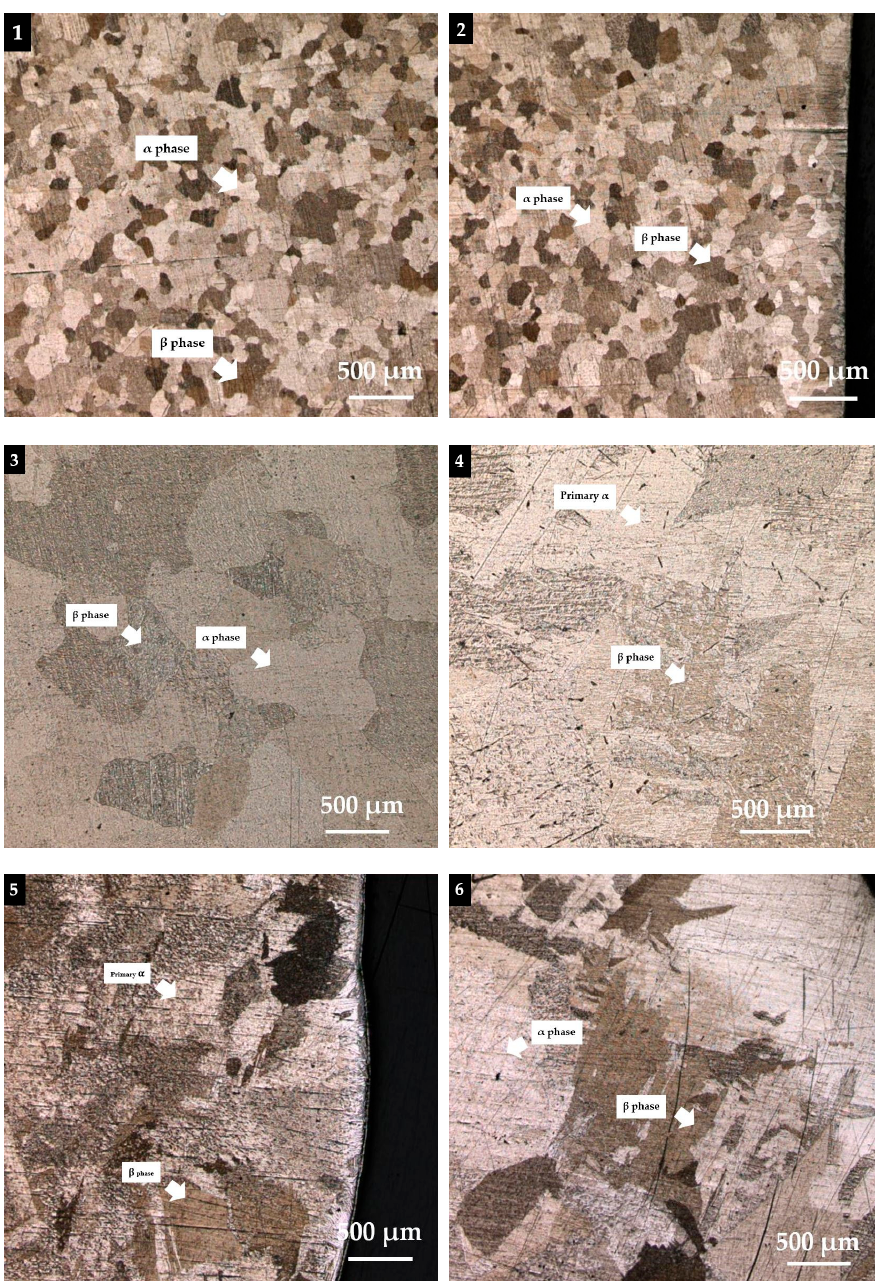
Figure 16. Microstructure of ( 1 ) Position 1, ( 2 ) Position 2, ( 3 ) Position 3, ( 4 ) Position 4, ( 5 ) Position 5, and ( 6 ) Position 6 of the hot-wire plasma welding test.